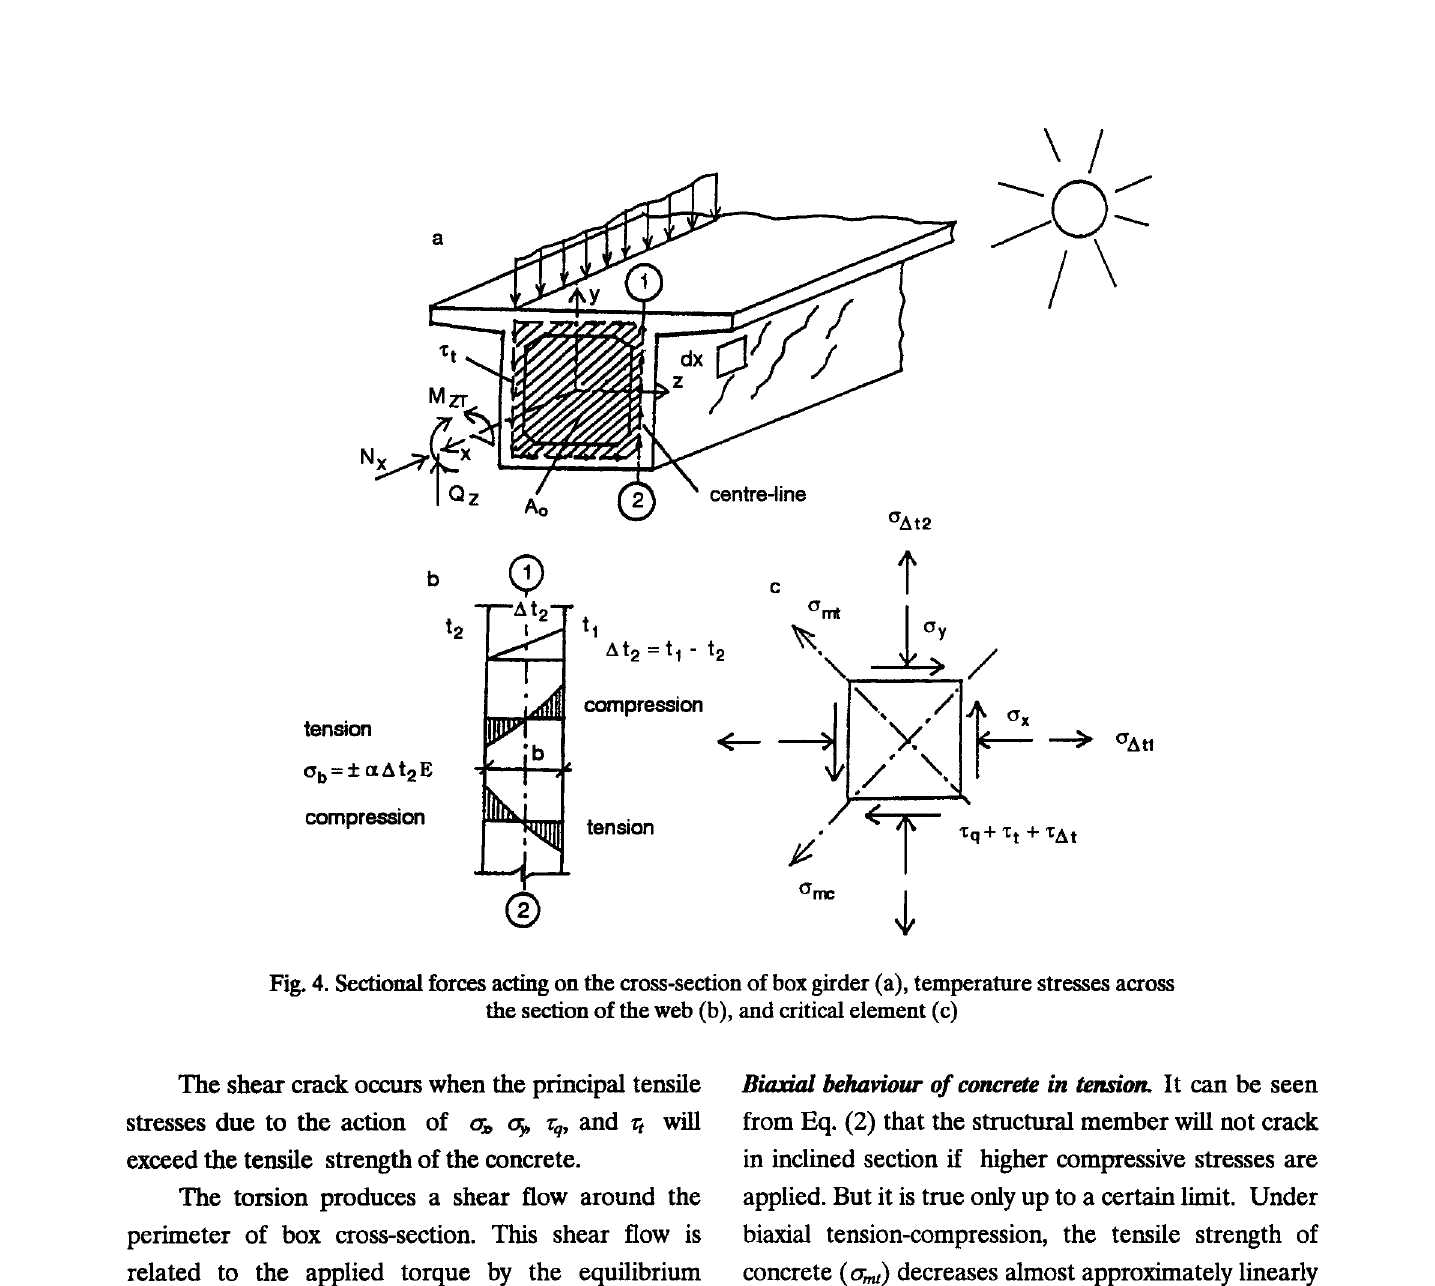
Fig. 4. Sectional forces acting on the cross-section of box girder (a), temperature stresses across the section of the web (b), and critical element